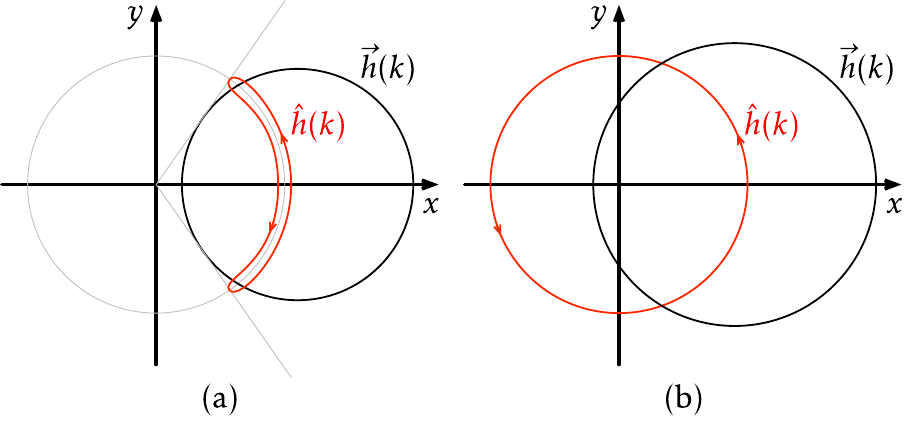
 Figure 3. The trajectories of h k ( ) and ˆ h k ( ) ( a ) in the topologically trivial phase ( λ < 0) and ( b ) in the topological phase ( λ >